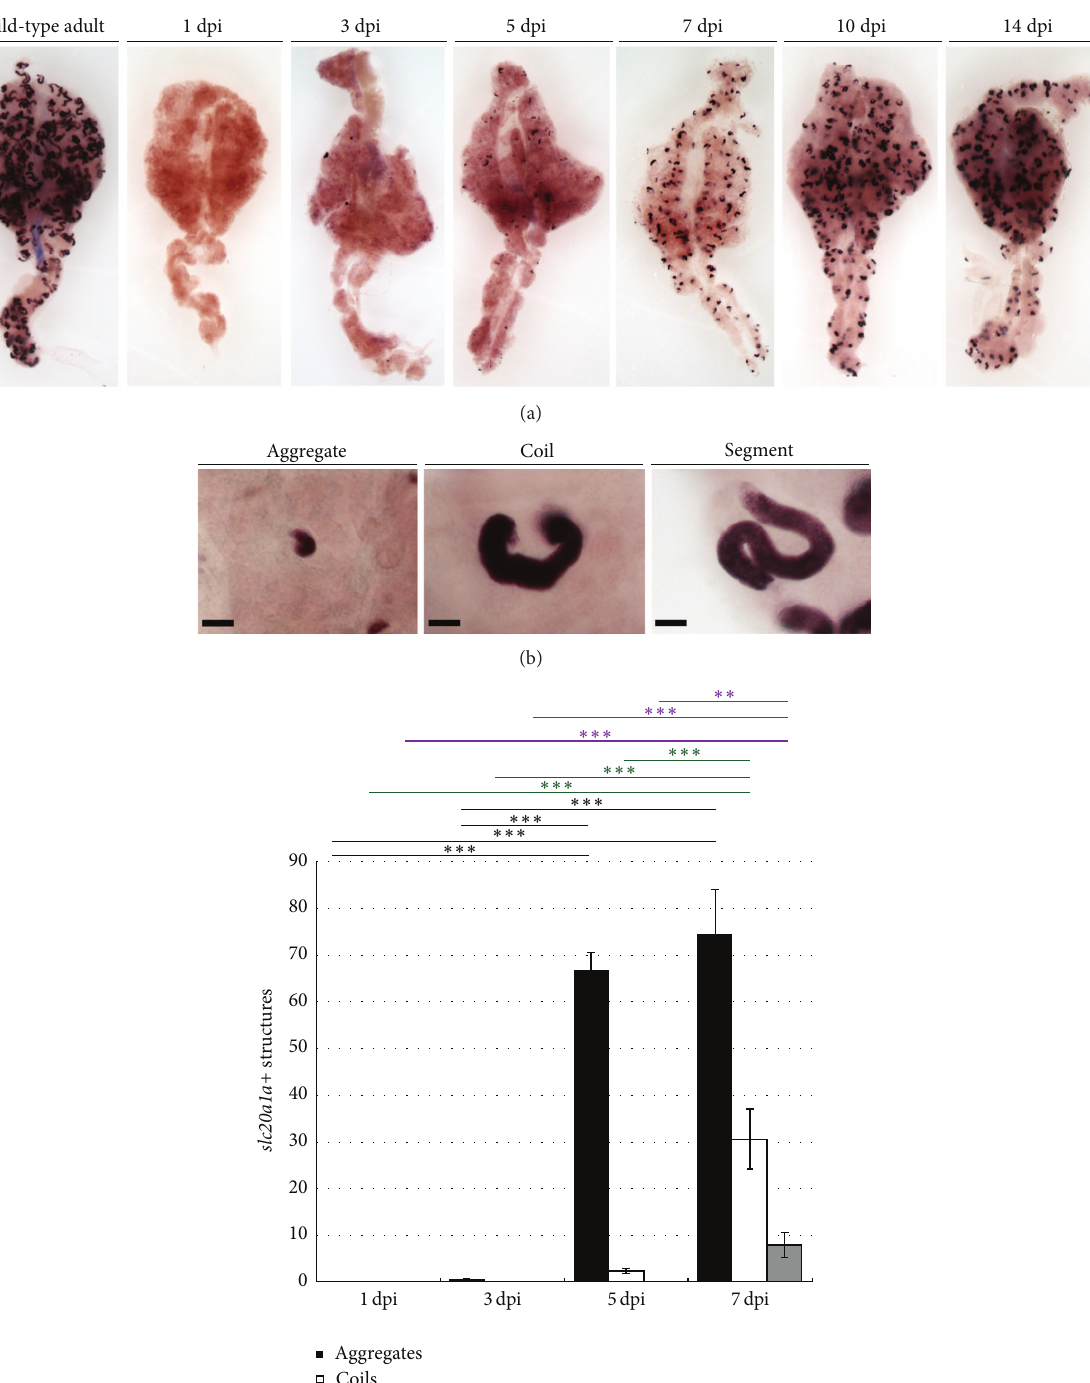
Figure 3: Dynamics of slc20a1a expression over the course of zebrafish adult kidney injury and regeneration. (a) Whole mount in situ hybridization of adult kidneys over a two-week injury time course revealed the initial absence of slc20a1a transcripts, followed by an increase in transcript levels and domains to near-normal levels by 14 dpi. Throughout the time course, new nephrons first appeared as small cellular aggregates that form coils and eventually elongated into PCT segments that are indistinguishable from preexisting, regenerated PCT tubules. 3x magnification. (b) Representative images of the progressive stages of nephron formation. Scale bar, 25 𝜇 m. (c) Quantification shows that slc20a1a positive structures during regeneration. Labels: ∗∗ indicates 𝑃 < 0.01 ; ∗ ∗ ∗ indicates 𝑃 < 0.001 ; black indicates aggregate; green indicates coil; purple indicates